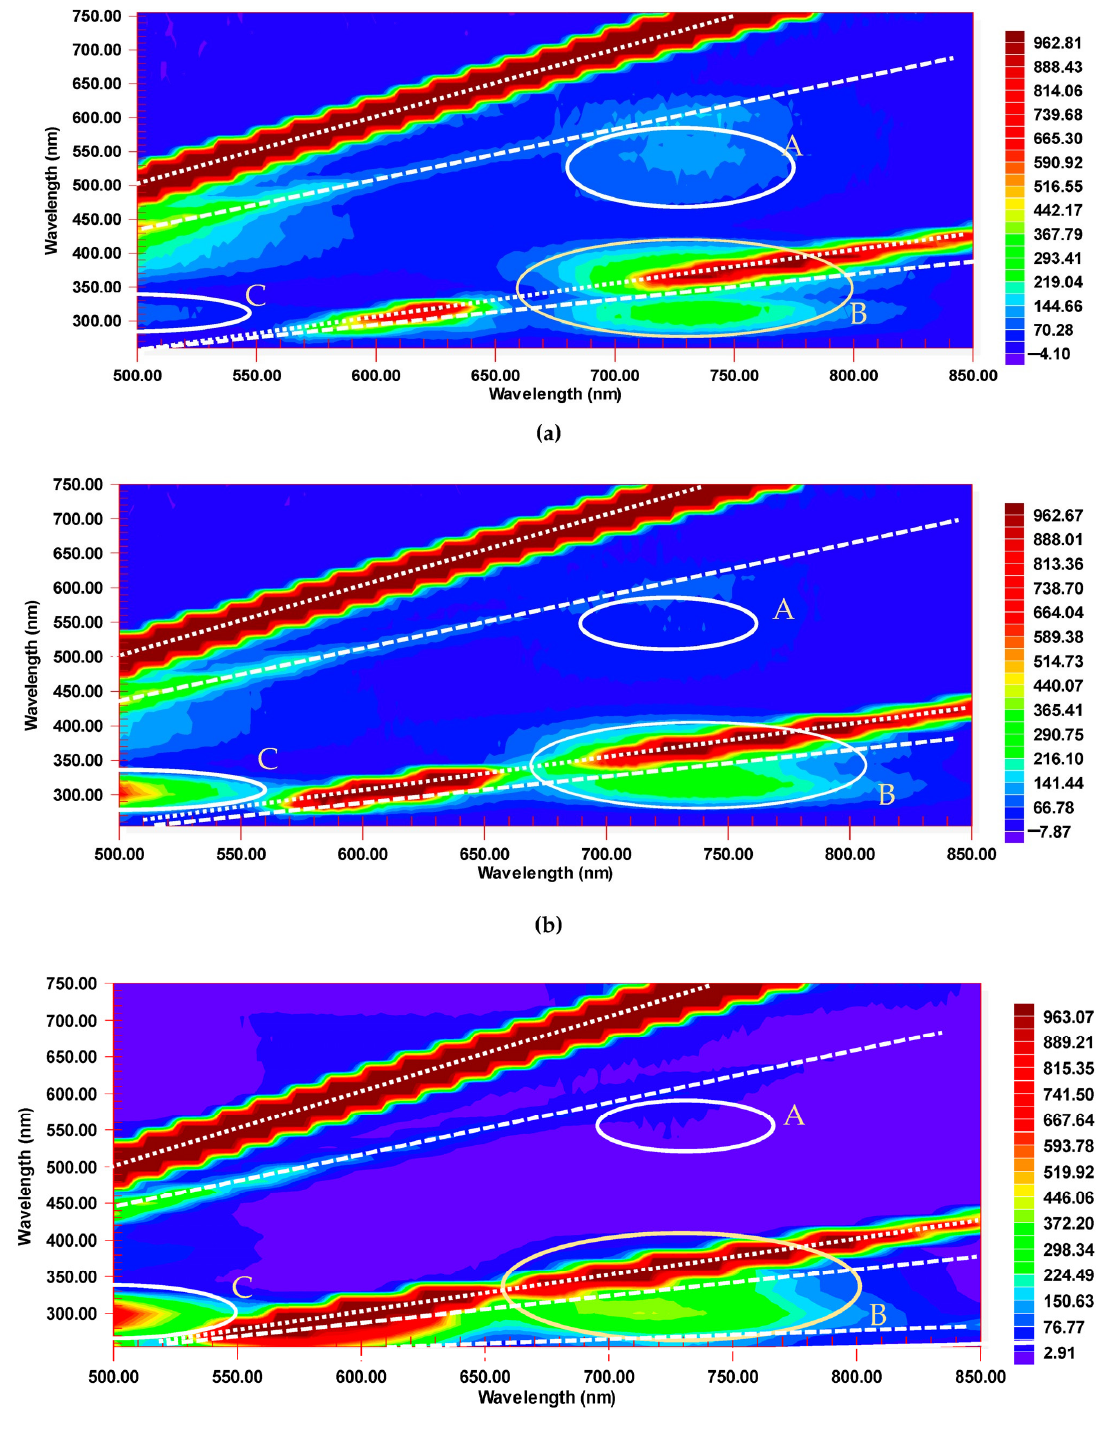
Figure 3. Excitation–emission fluorescence maps of C 60 in ( a ) benzene, ( b ) toluene, and ( c ) n -hexane, 50.0 µM. Excitation/emission slits, 20/20 nm; detector voltage, 870 V; Scanning pitch, 15 nm. Y -axis is excitation, X -axis is emission. Regions of fluorescence A, B, and C are marked by white circles. Lines of scattering are denoted by diagonal white lines: 1st-, 2nd-, and 3rd-order Rayleigh (dotted) and 1st and 2nd Stokes Raman (dashed).